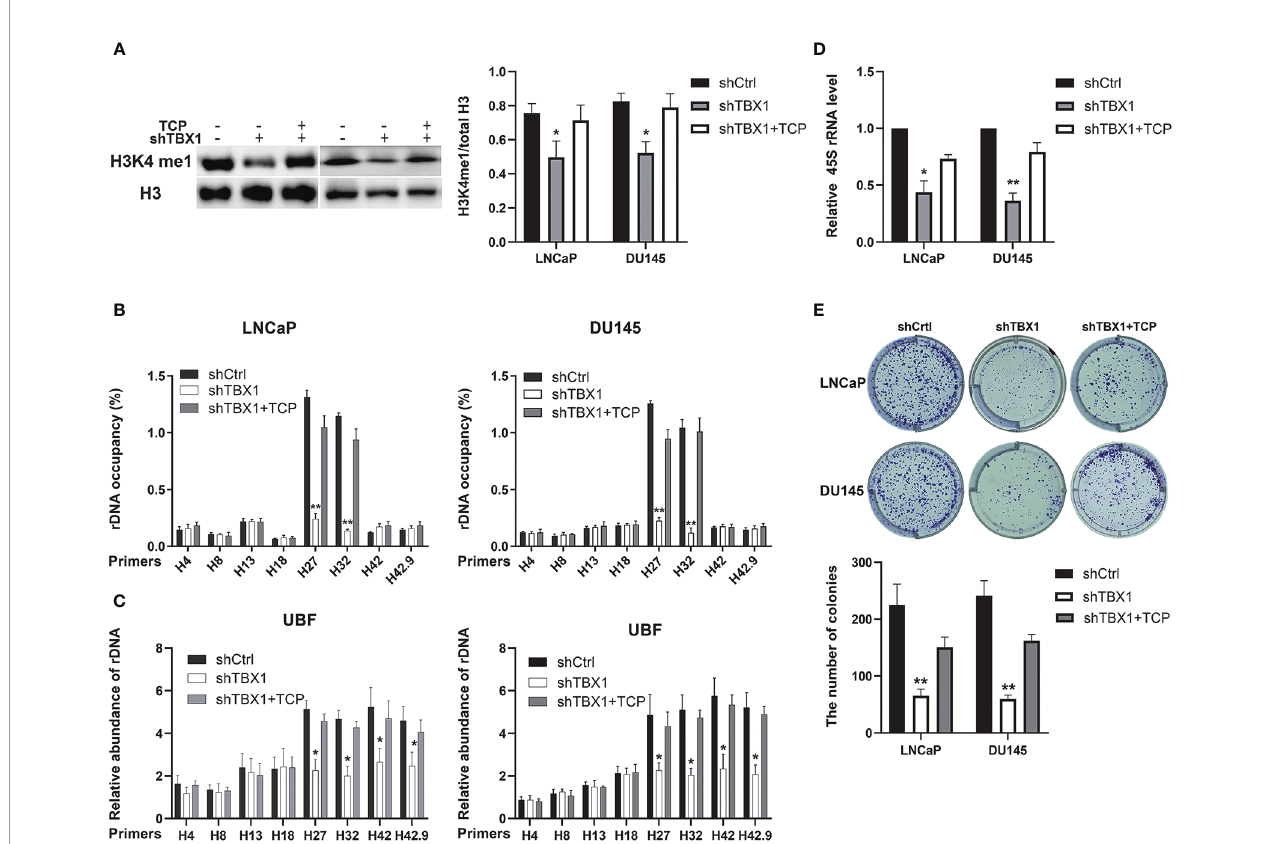
FIGURE 7 | H3K4me1 enhancement partially counteracts the effect of TBX1 silencing. (A) Left, Western blot results showing that TCP treatment partially rescues the decrease in H3K4me1 due to TBX1 silencing. Right, quantitative results of the left panel. (B) CHIP – qPCR analysis results showing that TCP treatment partially rescues the observed decrease in level of H3K4me1 binding with rRNA genes due to TBX1 silencing. (C) CHIP – qPCR analysis results showing that TCP treatment partially rescues the decrease in level of UBF binding with rRNA genes due to TBX1 silencing. (D) qPCR analysis results showing that TCP treatment partially rescues the decrease in 45S rRNA due to TBX1 silencing. (E) TCP treatment partially rescues the decrease in colony formation due to TBX1 silencing. Upper panel, representative images of colony formation. Lower panel, quantitative analysis of colon numbers. The data represent the mean ± SD of three independent experiments. * p < 0.05; ** p < 0.01, shTBX1 vs. shTBX1+TCP/shCtrl. Tranylcypromine, TCP; upstream binding factor,